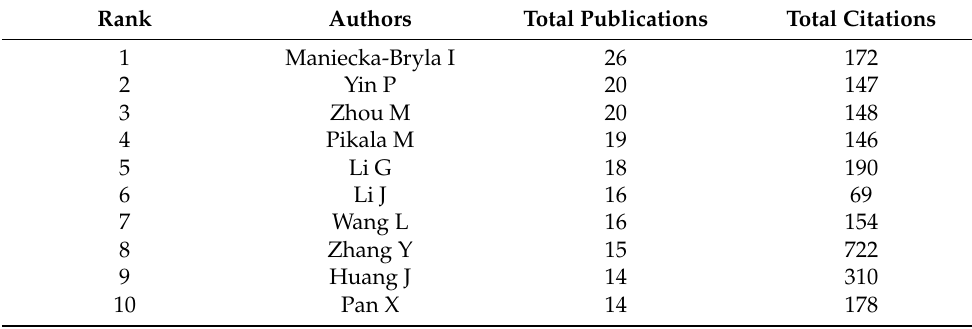
Table 3. The top 10 most productive authors of articles on premature